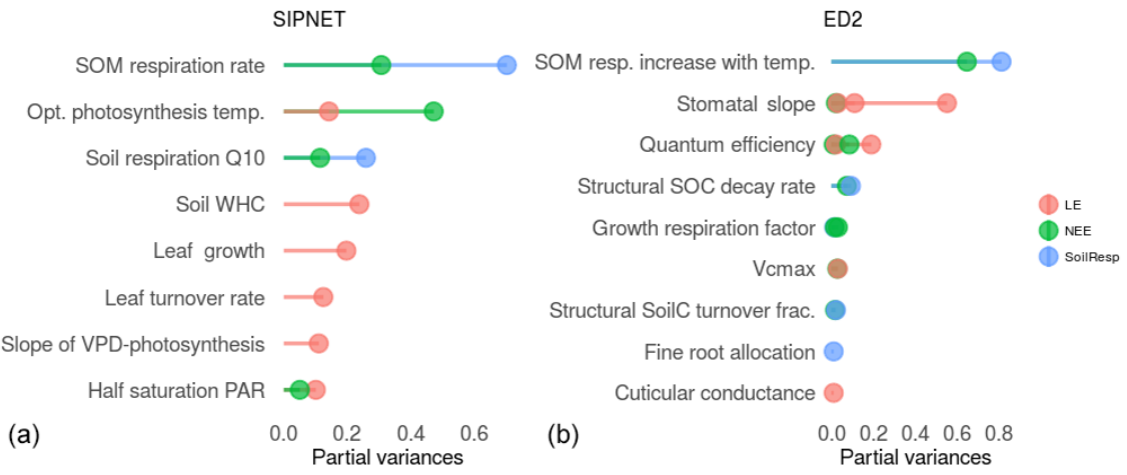
Figure 2. Results of uncertainty analysis in PEcAn for plant physiological and soil biogeochemistry parameters of SIPNET (a) and ED2 (b) . The longer the bar the more that parameter contributes to the model predictive uncertainty. The parameters shown above that contribute more than 5% (1%) of uncertainty were chosen to target in calibration of SIPNET (ED2) and are shown